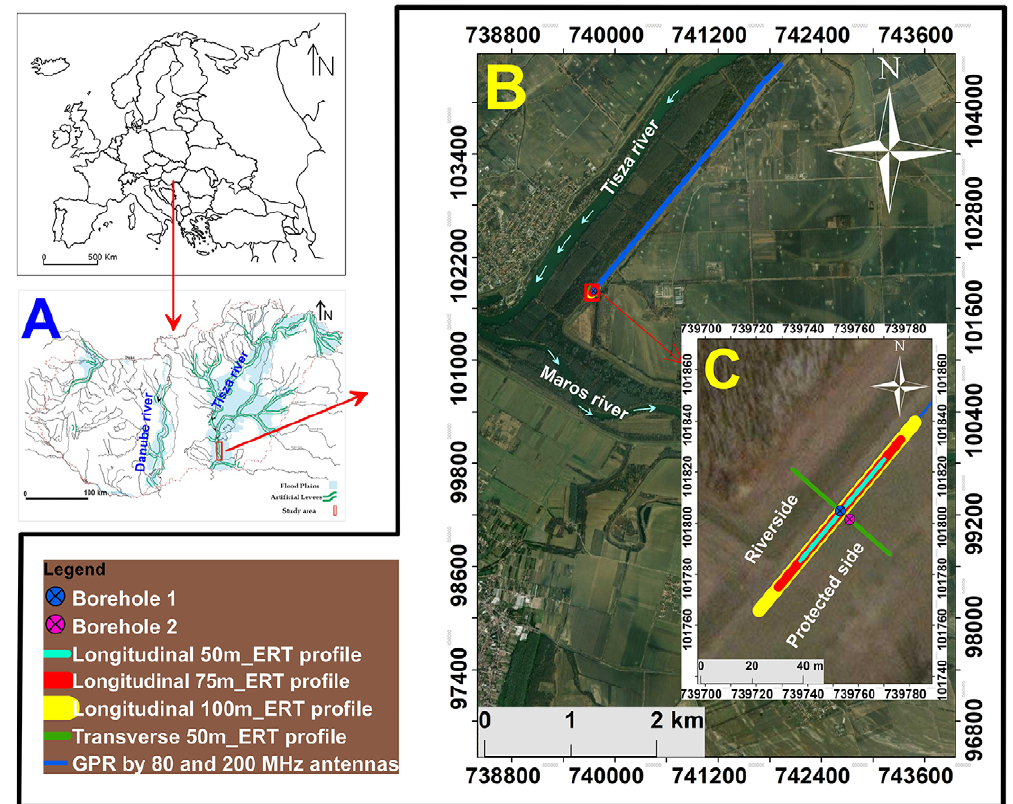
Figure 1. The location of the study area and the survey plan. A) Artificial levees and potential floodplains along the rivers of Hungary (modified after OVF 2014). B) Survey track of GPR profiles and the location of the ERT measurement site. C) Location of ERT profiles and